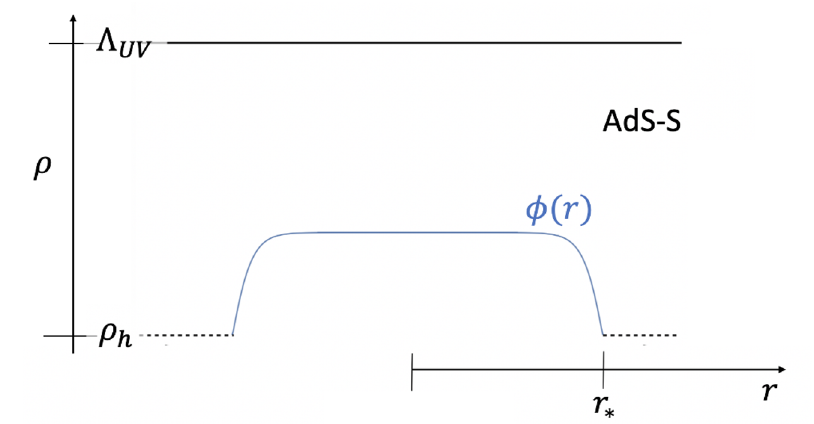
Figure 2. An example of the profile of the bounce ansatz, obtained by solving the EoM resuling from the action of eq. (3.9). The black dashed lines represents the black-brane horizon and the blue curve shows the IR-brane profile specified by φ ( r )